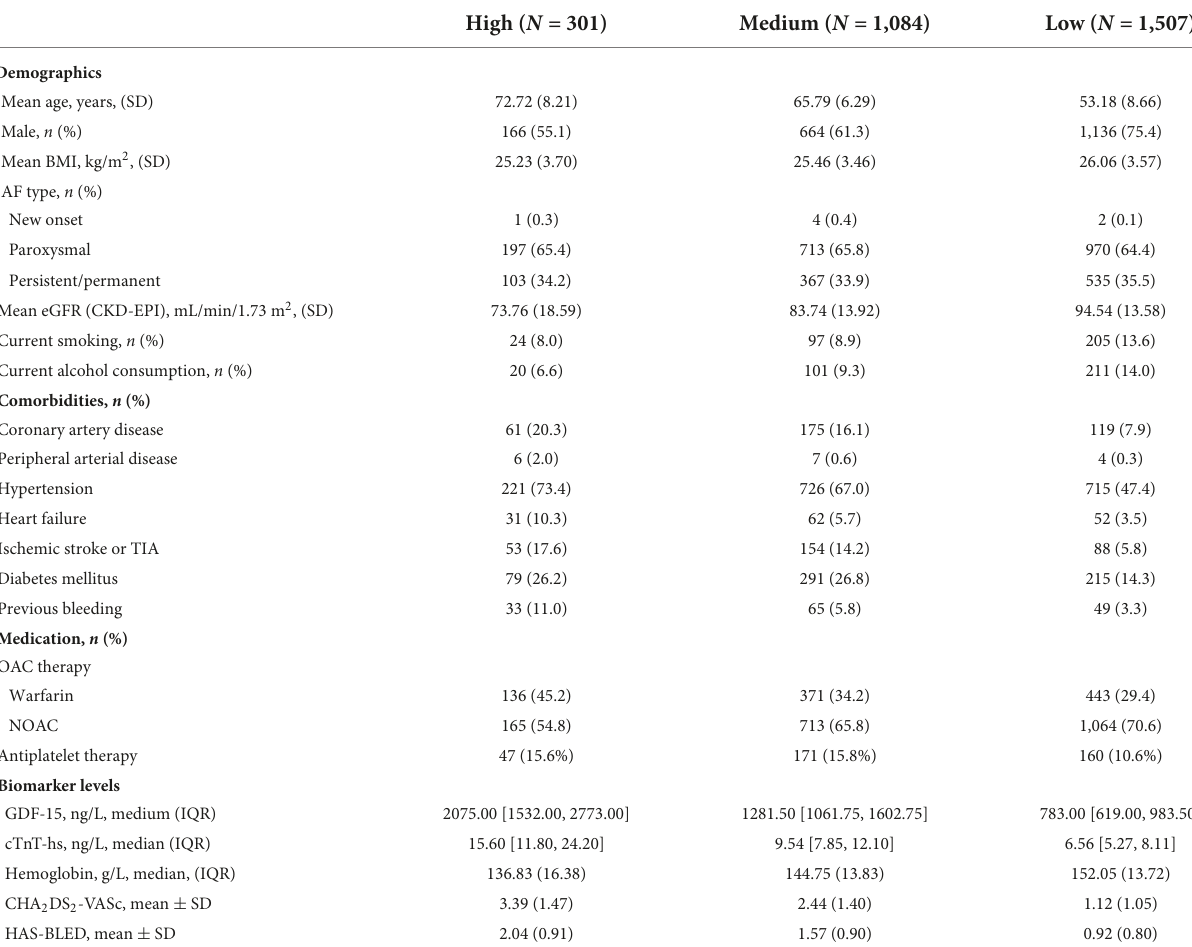
TABLE 1 Demographic and baseline characteristics stratified by the ABC-bleeding risk